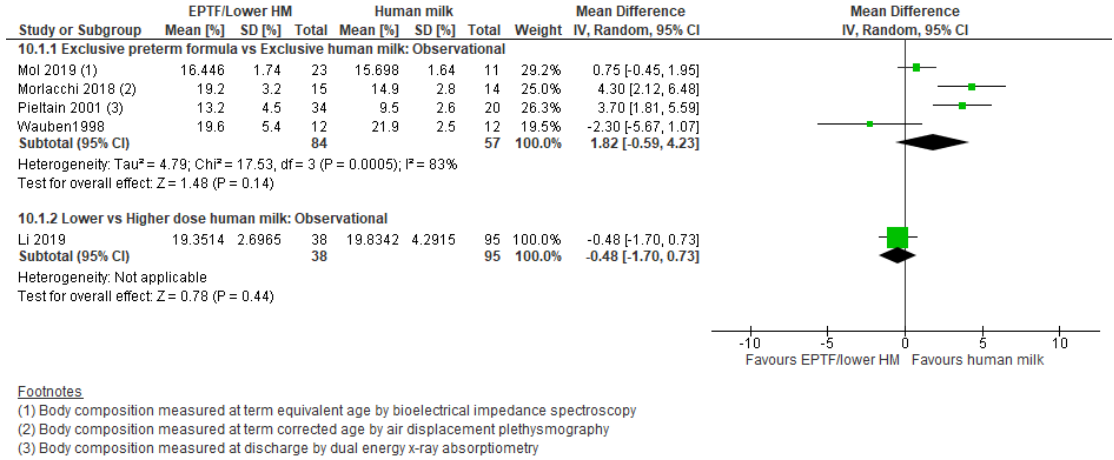
Figure 10. Forest plot of mean difference in change in % fat mass and human milk intake.